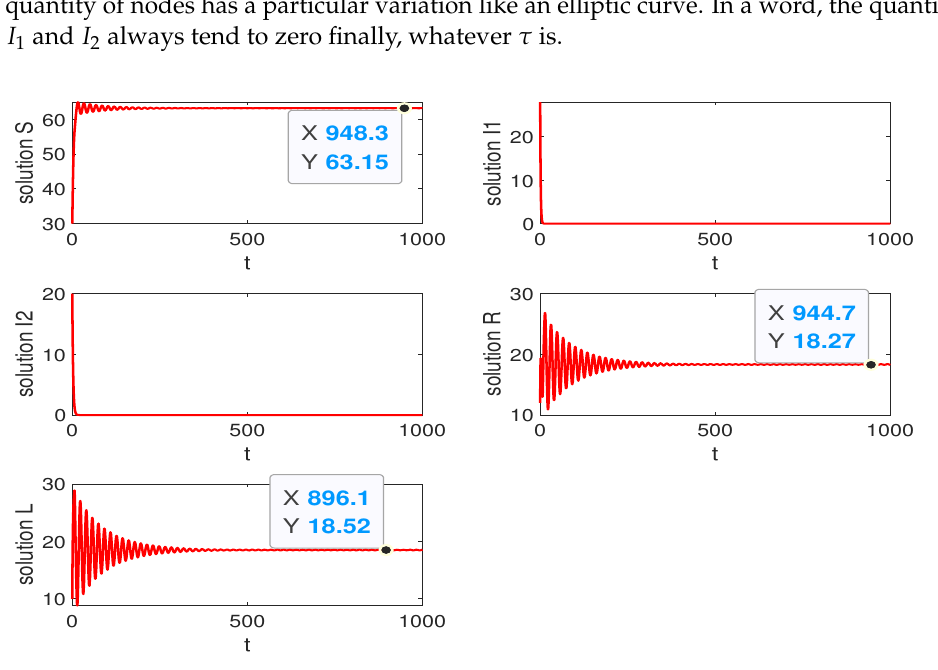
Figure 2. The variation in the state nodes under τ = 6.368 < τ 10